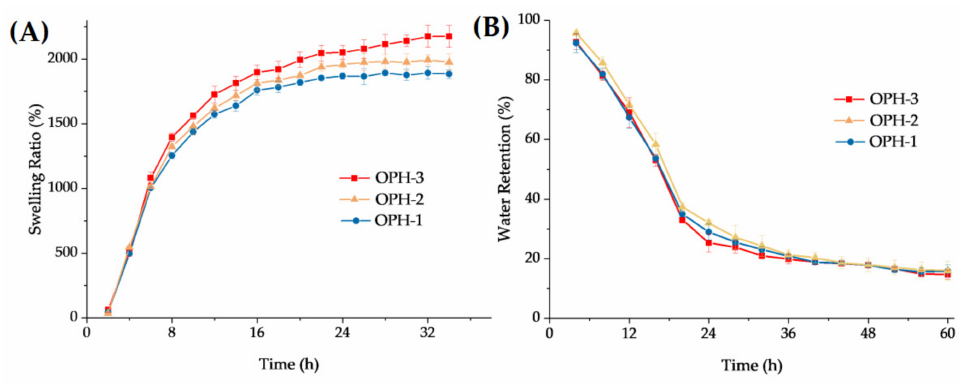
Figure 5. Swelling ratio ( A ) and water-retention ratio ( B ) of OPHs (mean ± SD, n = 3).